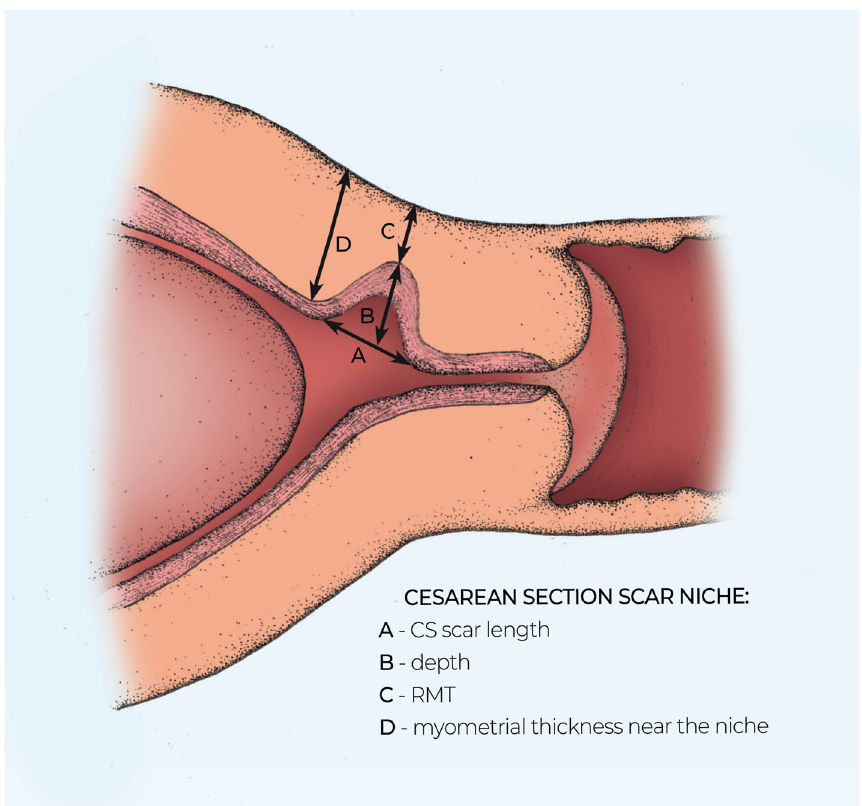
Figure 3. Schematic diagram showing Cesarean scar niche dimensions in the sagittal plane. A, niche length—the length of a hypoechoic part of the niche; B, depth of the hypoechogenic part of the niche; C, residual myometrial thickness; D, the thickness of the myometrium adjacent to the niche.